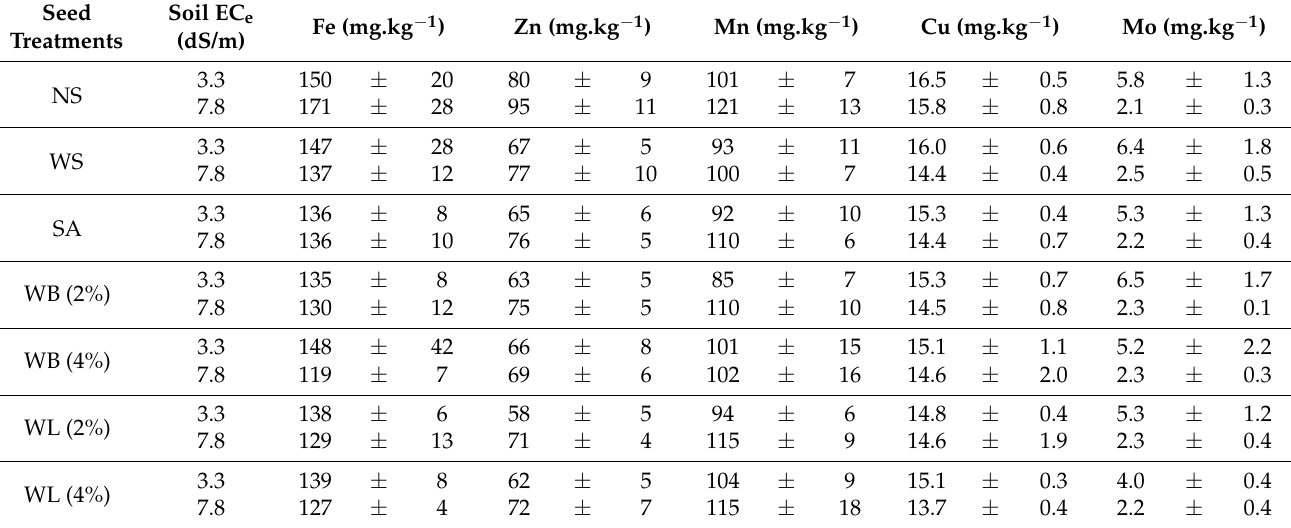
absence and presence of salinity stress. When compared with WS and SA seed treatments, willow extracts caused a dramatic increase in protein levels. Under saline condition, the protein concentration was increased by 12% with WB and 27% with WL applications. Table 5. Changes in micronutrient (Fe, Zn, Mn, Cu, Mo) concentrations of 2-week-old soil-grown maize ( Zea mays cv. Caramelo) shoots in response to salinity (non-saline, EC e = 3.3 dS/m; saline, EC e = 7.8 dS/m) and different seed treatments (NS, non-soaked; WS, water-soaked; SA, salicylic acid (0.5 mM); WB, willow bark extract (2% or 4% w / v ); WL, willow leaf extract (2% or 4% w / v )).